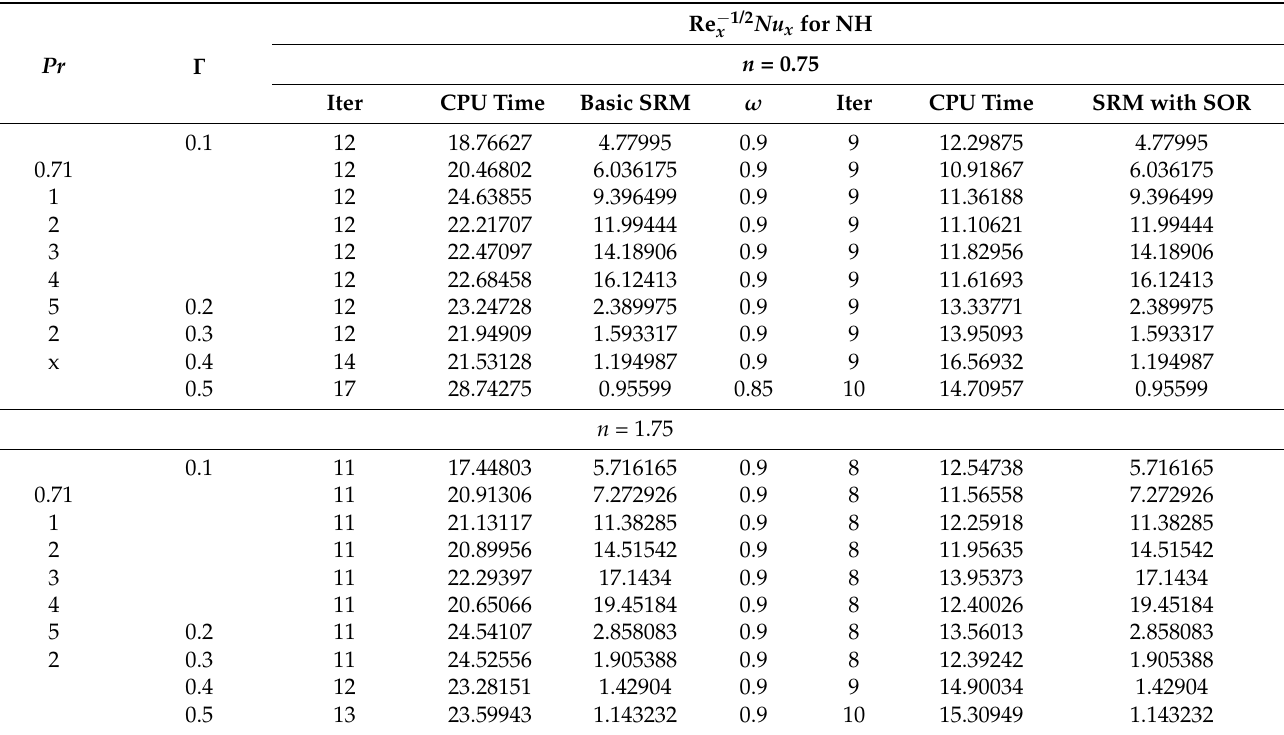
Table 2. Numerical values for Re − 1/2 x Nu x for NH at the surface of the sheet for various values of Pr & γ with M = 0.5, α = 0.5 & A =